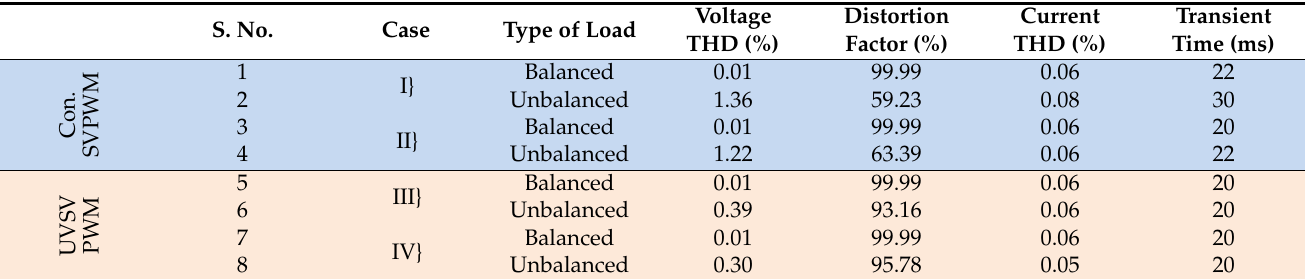
Table 2. Summary of simulation